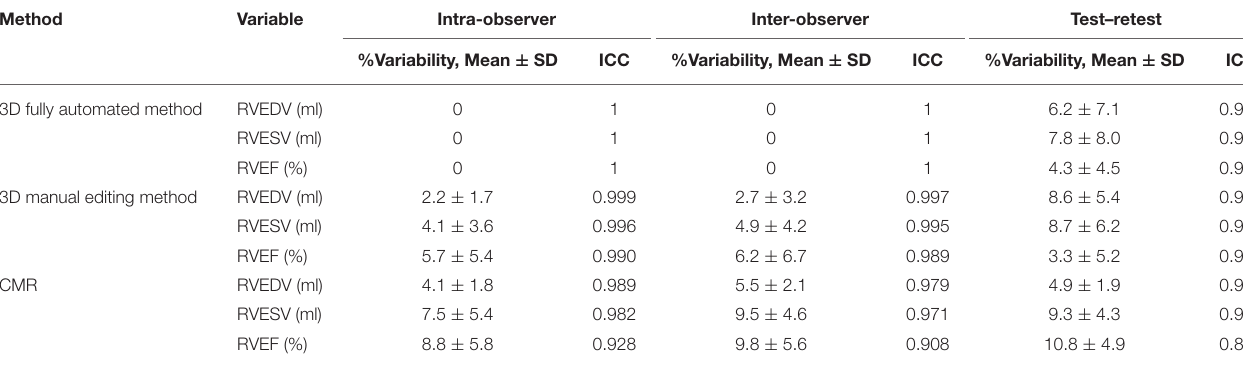
TABLE 6 | Reproducibility of 3D auto RV measurements with/without manual editing and CMR for RV volumes and EF.